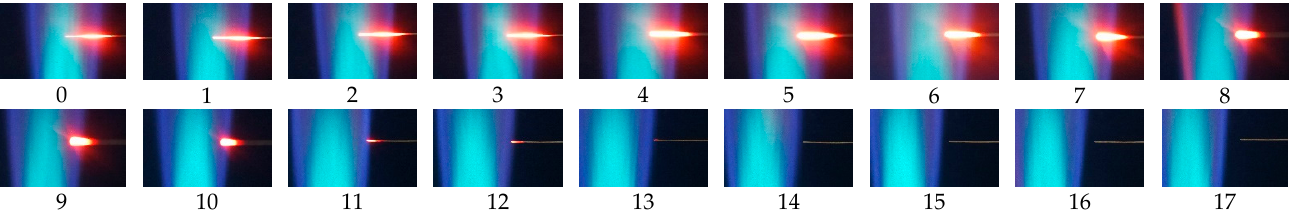
Δ = 0–17 mm under Δ = 50 mm. The numbers below each image represent the values of 2a 1a